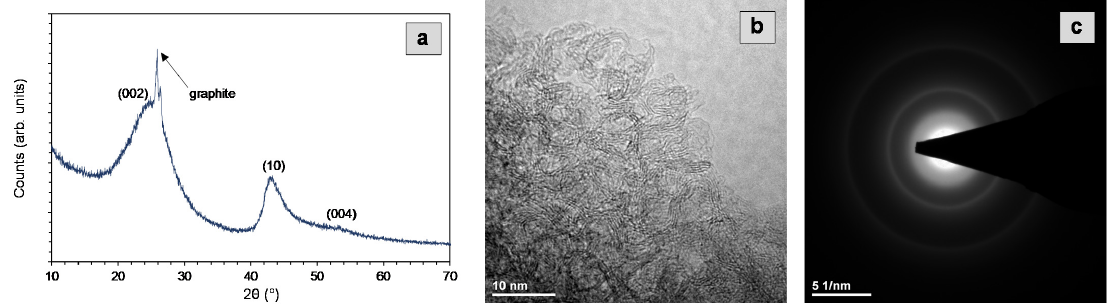
Figure 1. The structure of the carbon support: ( a ) XRPD pattern, ( b ) HRTEM image, ( c ) SAED pat-